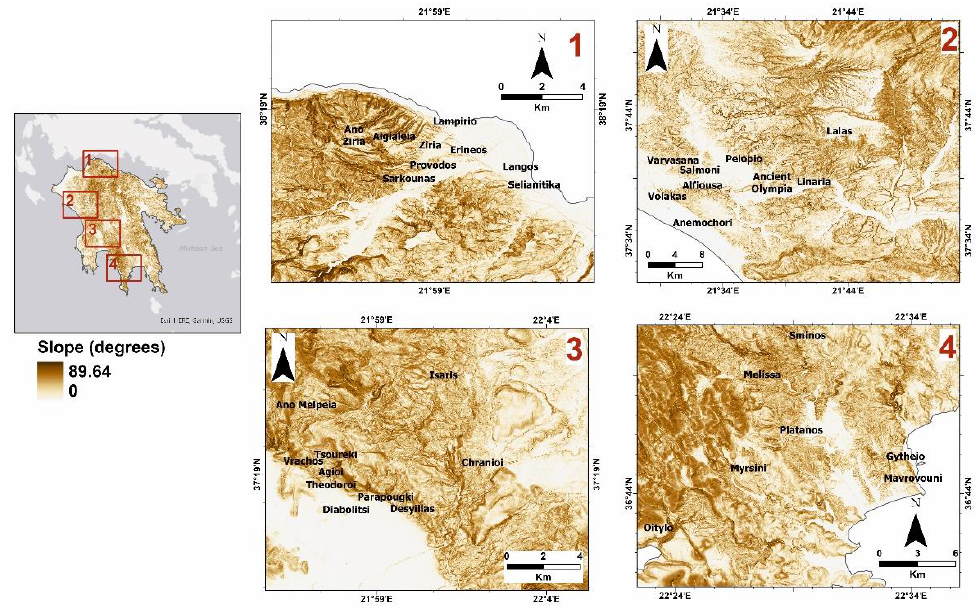
Figure 8. Morphological slopes of the fire-affected areas in Peloponnese.